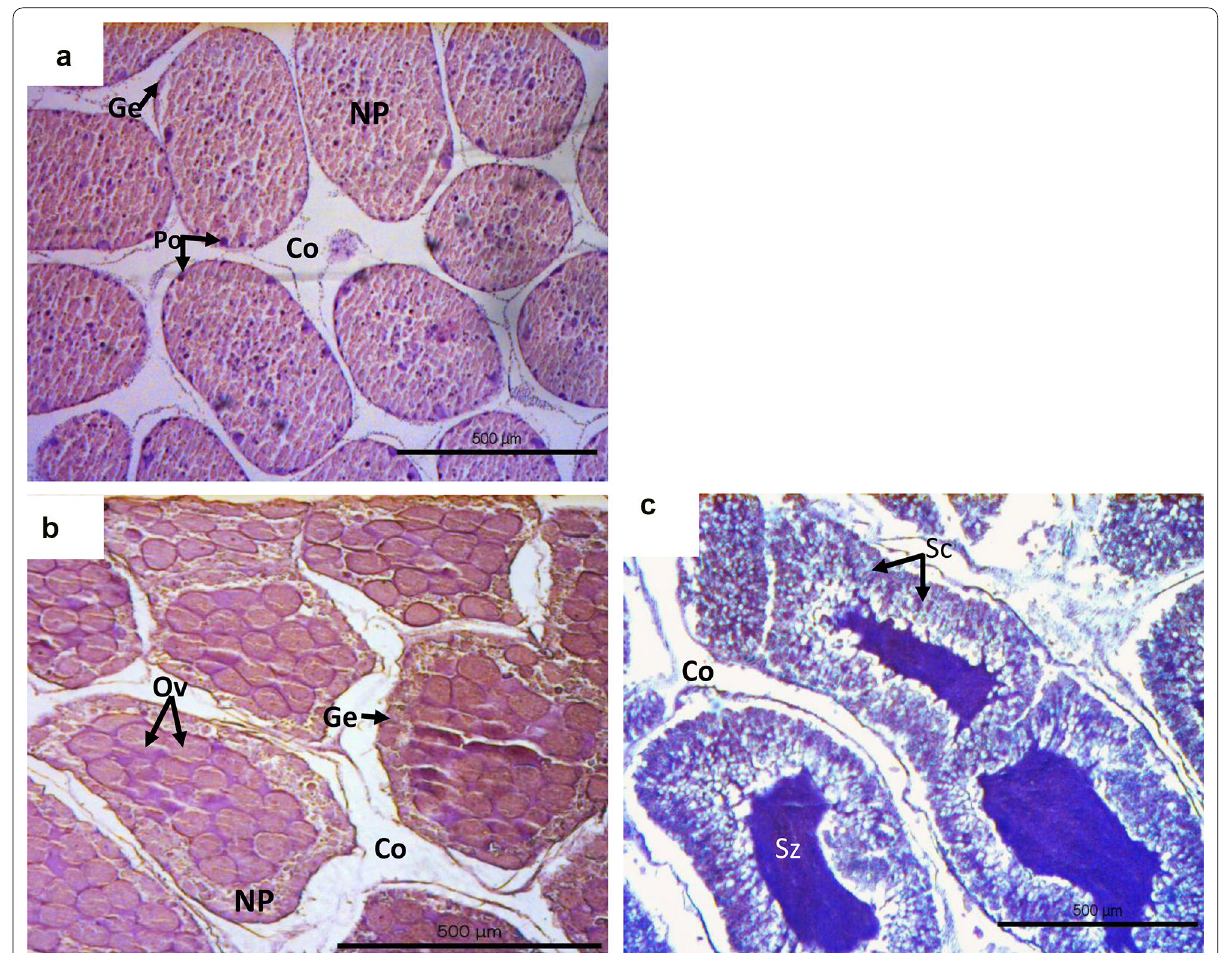
Fig. 8 Reproductive stages according to Bronstein et al. [11] of the studied Diadema setosum population in Dodecanese island complex, observed in December 2019 and July 2020 samplings. A Stage II (recovering): clusters of previtellogenic oocytes formed in the ovarian germinal epithelium which may also occupy the central space of the female gametes. B , C Stage IV (mature): Ovaries ( B ) and testicular lumen ( C ) packed with mature ova and spermatozoa, respectively. Oocytes at different maturation stages are distinguished in the germinal epithelium. Ge germinal epithelium, Co coelom, NP nutritive phagocytes, Po previtellogenetic oocytes, Ov ova, Sz spermatozoa, Sc